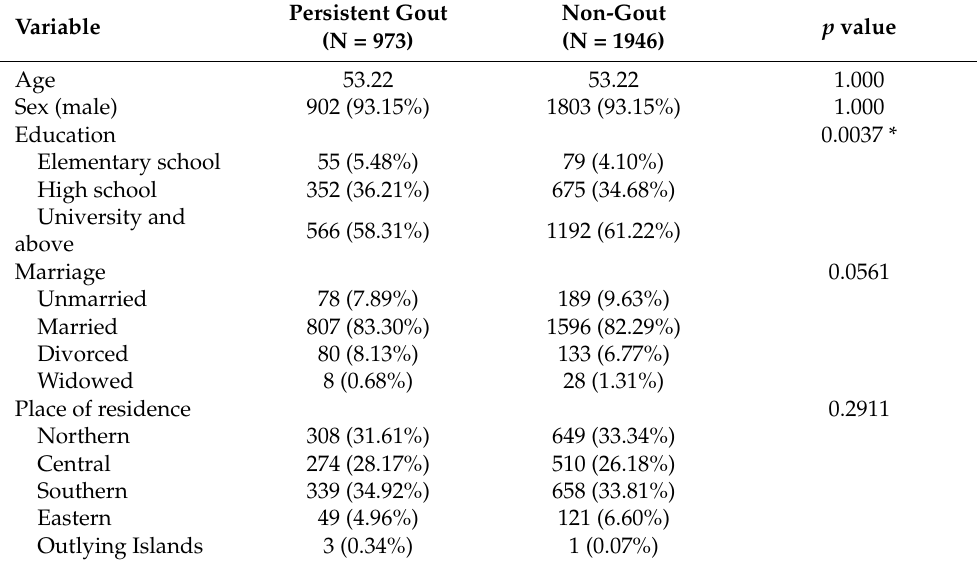
Table 1. Characteristics of the study